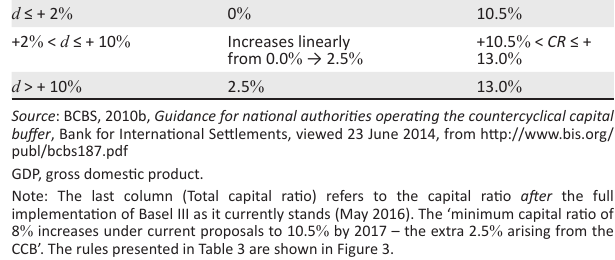
TABLE 2: Proposed Basel III countercyclical rules. Difference between credit/ GDP and long-run trend